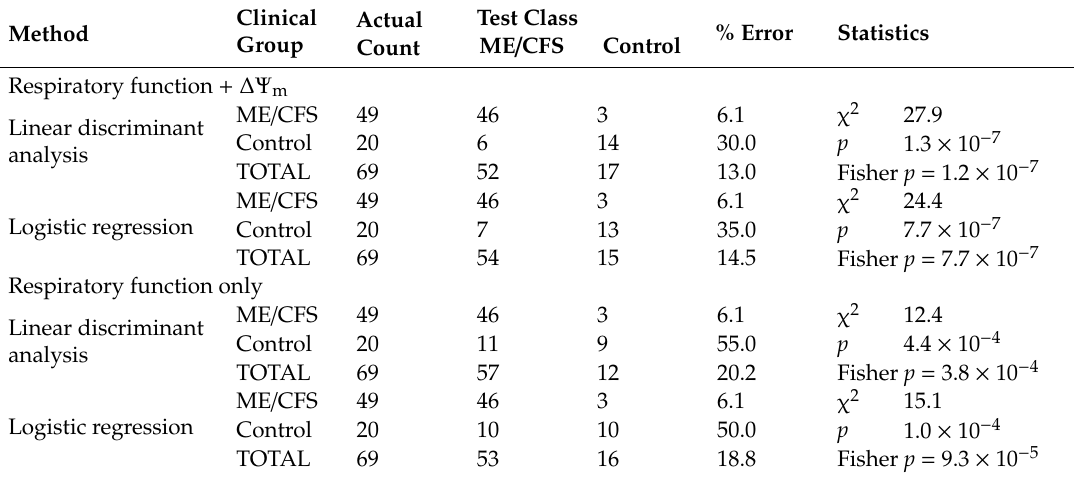
Table 2. “Confusion matrix” analysis of lymphoblast respiratory function and mitochondrial membrane potential ( ∆Ψ m